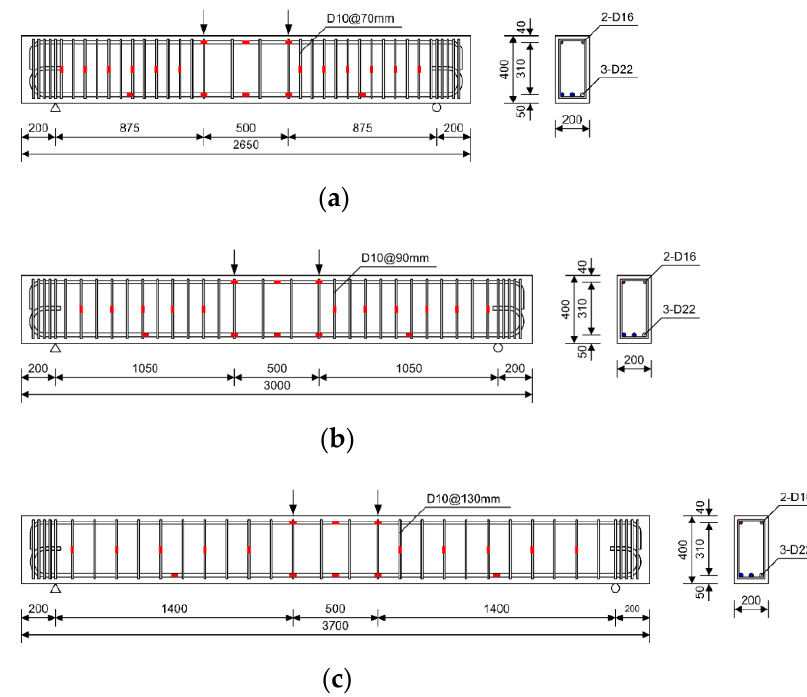
Figure 3. Details of typical specimens [8,9]: ( a ) B6-2.5b; ( b ) B6-3.0b; ( c ) B6-4.0b (unit: mm).